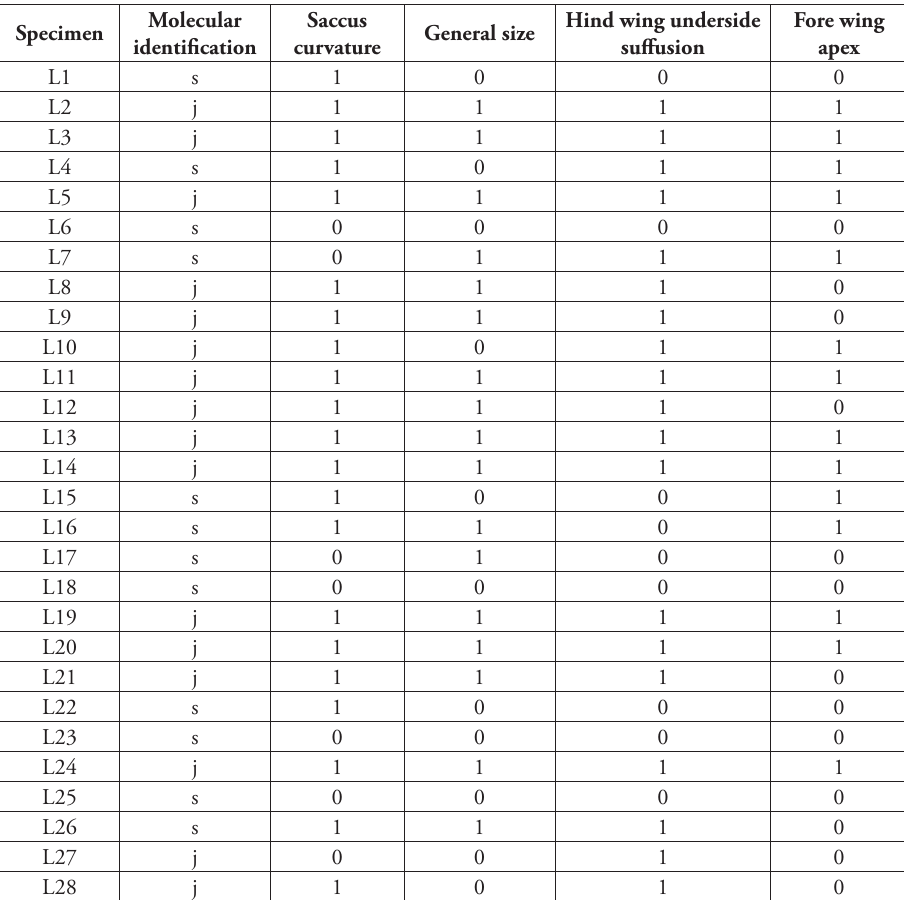
Table 7. Additional characters: the saccus curvature, general size, hind wing underside suffusion and fore wing apex shape, classified to arbitrary classes, in the studied male specimens of Leptidea sinapis and L. juvernica . Character states: saccus: 0 – straight, 1 – S-like curved; general size: 0 – large, 1 – small; hind wing underside suffusion below vein M3: 0 – with well-expressed lighter spots between veins, 1 – rather even, with very scarcely or not expressed lighter spots; fore wing apex: 0 – broadly rounded; 1 – more at- tenuated and acute. The typical L. sinapis phenotype corresponds to the character states 0000, the typical L. juvernica to